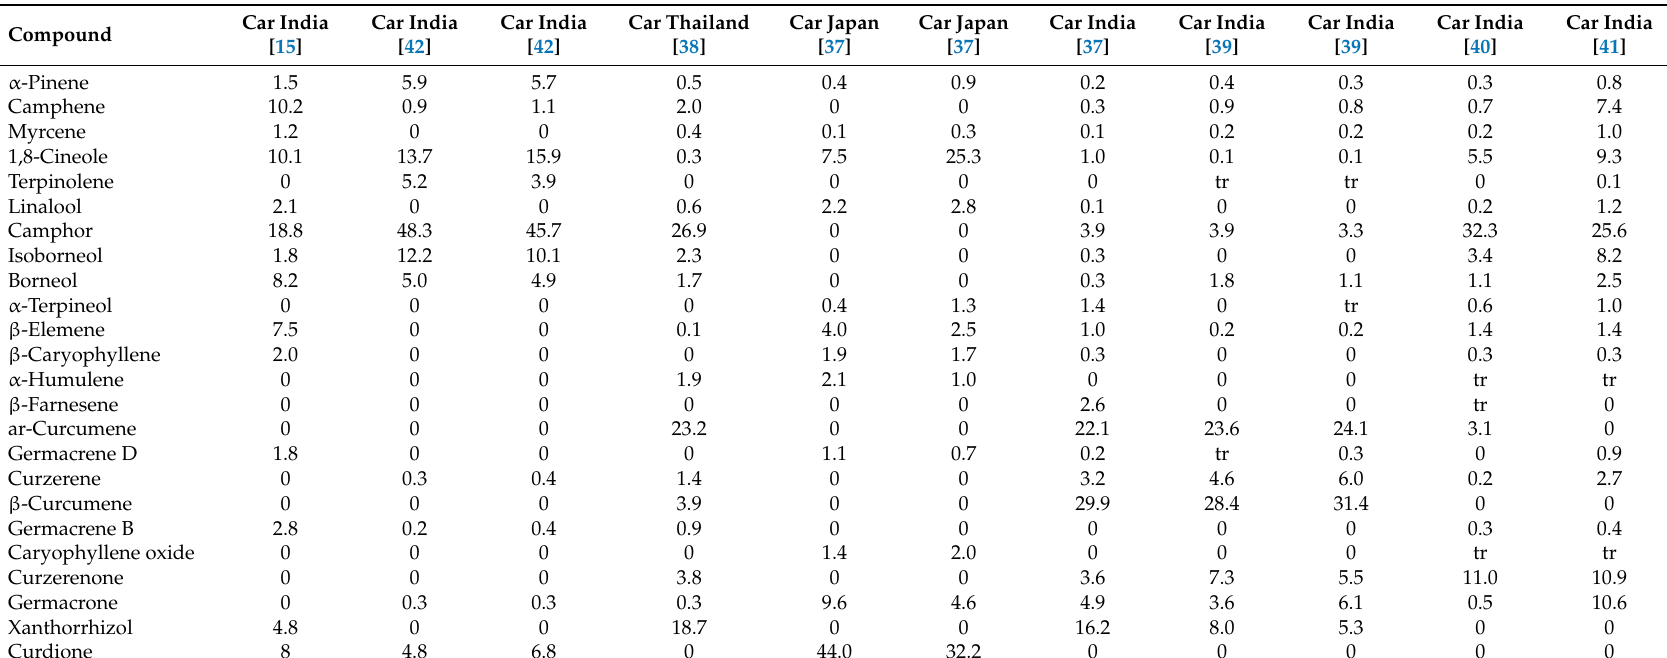
Table 2. Chemical composition of Curcuma aromatica rhizome essential